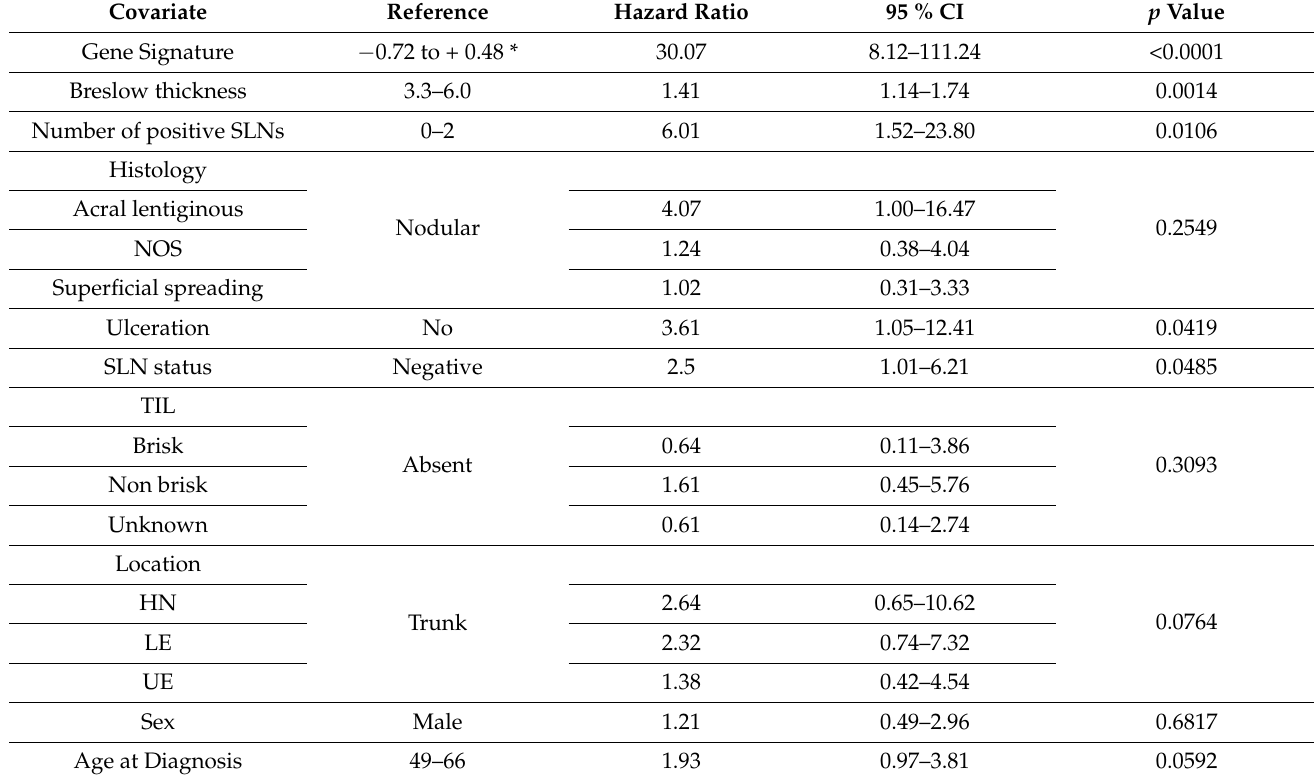
Figure 3. Recurrence-Free Survival by sentinel lymph node status adjusted for gene signature risk score low ( A ) and high ( B ). Survival curves are estimated from a bivariate proportional hazard regression model. Adjusting for risk score, sentinel lymph node status had no effect on PFS ( p = 0.602); gene signature risk score was highly significant ( p < 0.0001). Gray bands are (overlapping) 95% confidence intervals. Table 3. Proportional hazards regression for the association of progression-free survival with clinical covariates and the gene signature (CLGN, C1QTNF3, ADORA3, ARHGAP8, DCTN1, ASPSCR1,